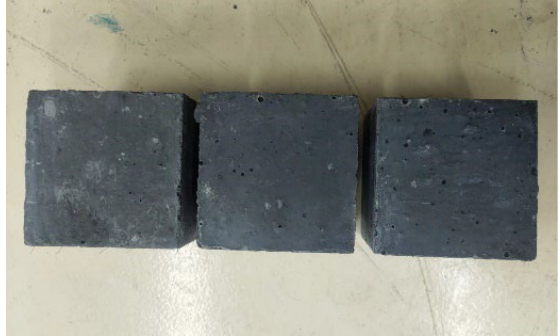
Figure 2. Cubic samples for unconfined compressive strength tests.